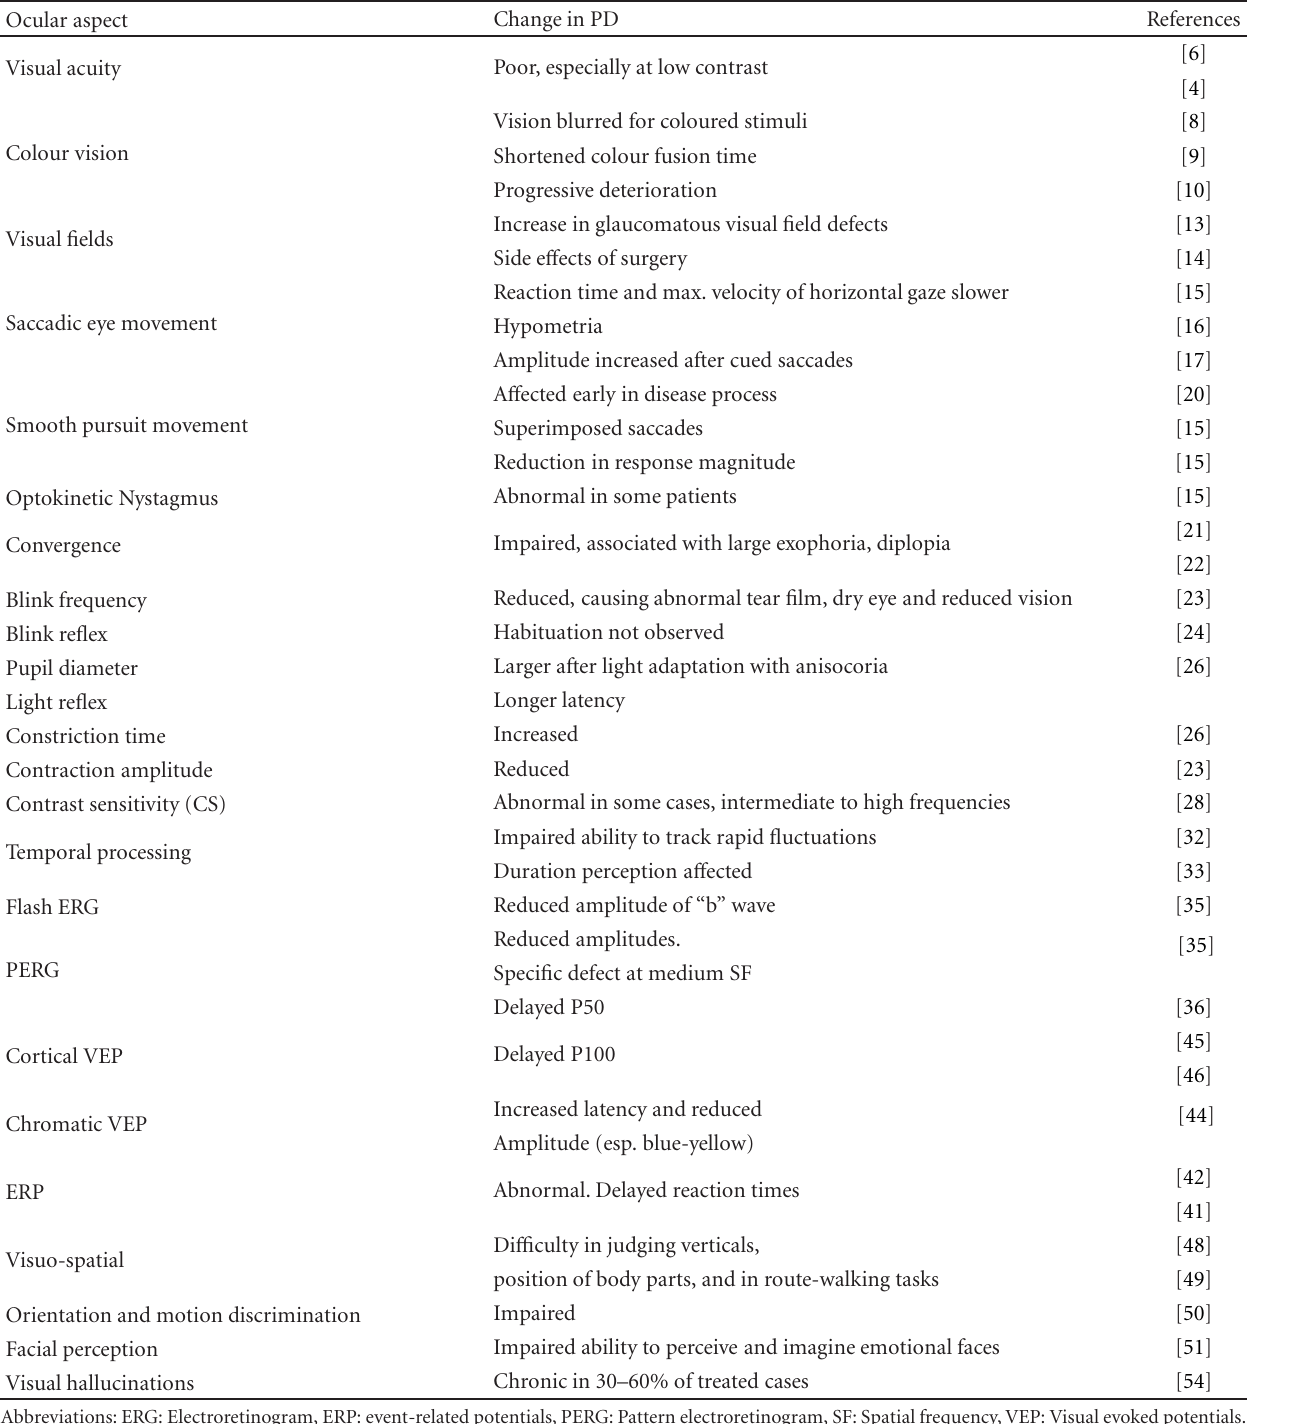
Table 1: Visual signs and symptoms of Parkinson’s disease